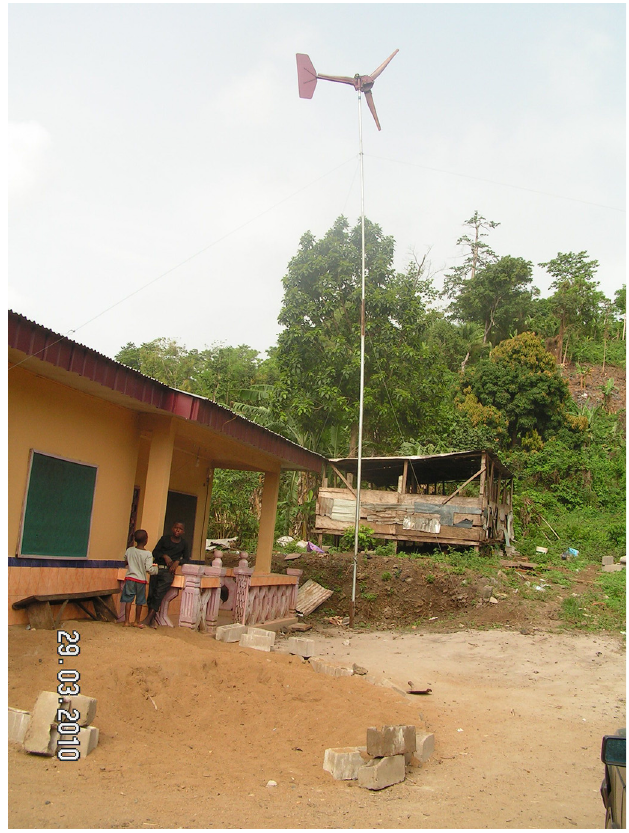
Fig. 8. Locally made wind plant with wooden blades in Limbe Cameroon (photo J.